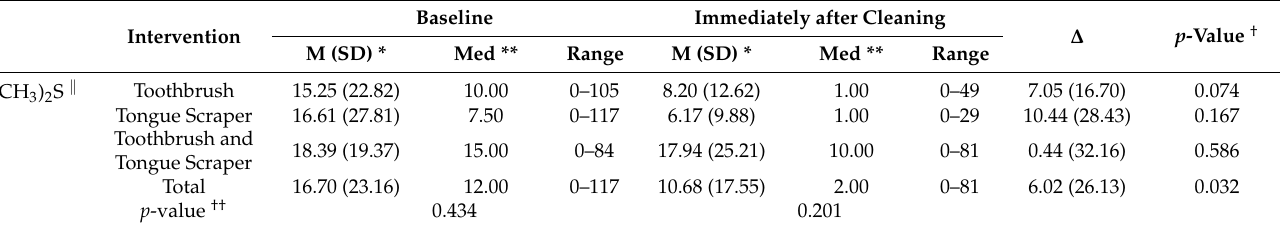
Table 9. Portable sulfide monitor score ((CH 3 ) 2 S).